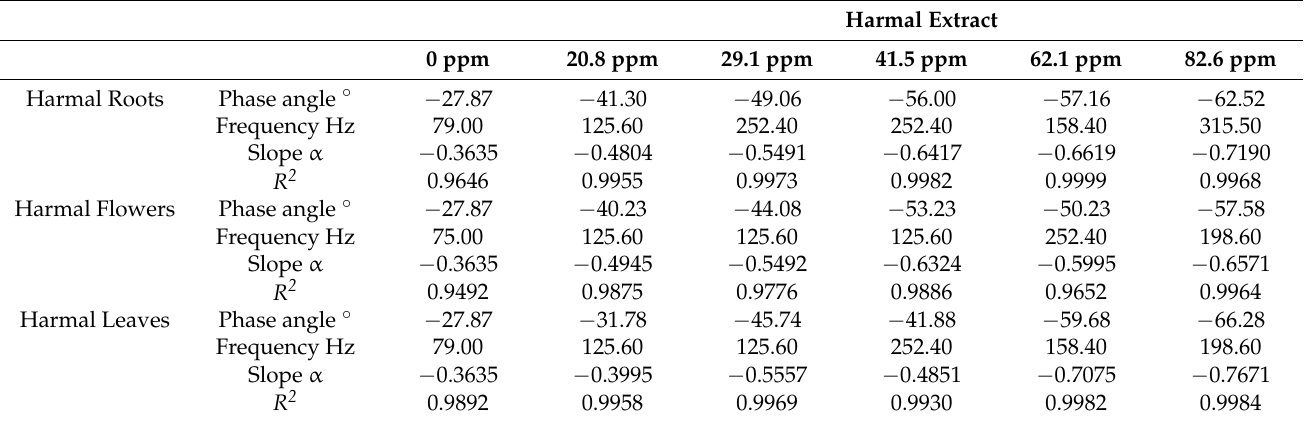
Table 7. Phase angles and alpha values (slopes) from the Bode phase and Bode plots for different types of Harmal extract at various